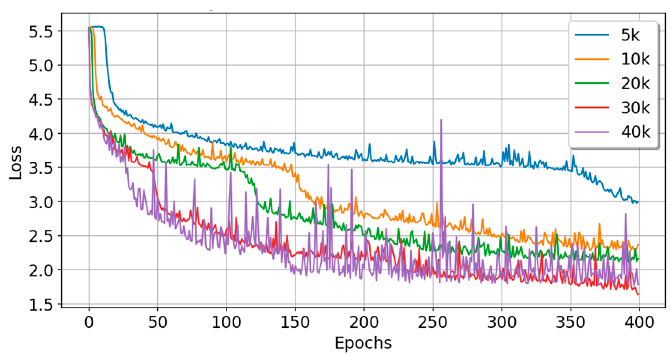
Figure 20. MLP loss values under different scales of data.